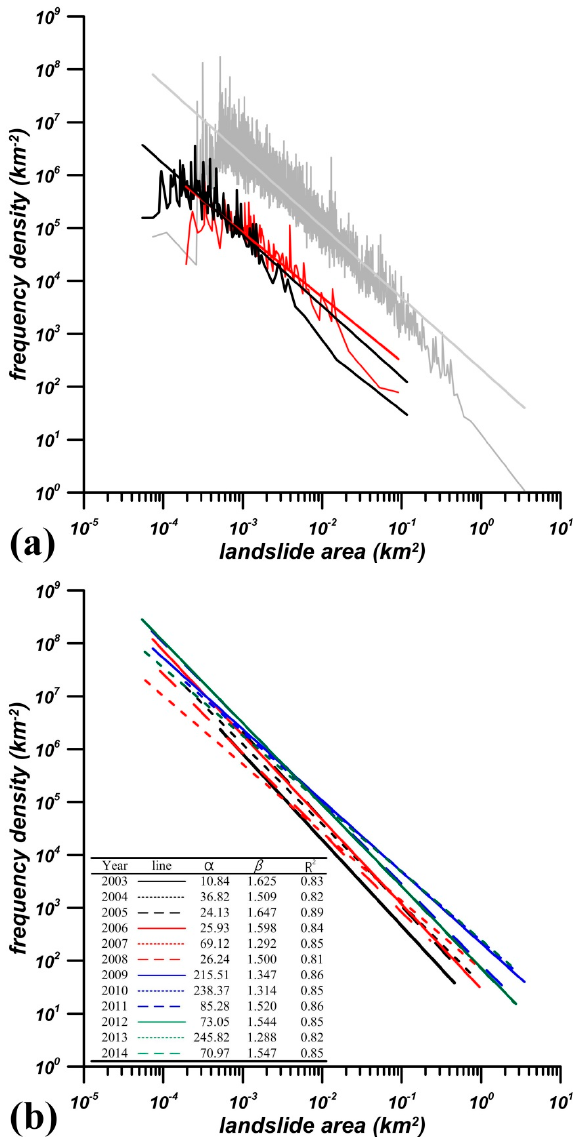
Figure 4. The landslide frequency density-area distribution and fitting lines in the LRW under 2009 Typhoon Morakot (gray line in ( a )), NoRW under 2010 Typhoon Megi (red line in ( a )), NsRW under 2015 Typhoon Soudelor (black line in ( a )), and LRW from 2003 to 2014 ( b ).